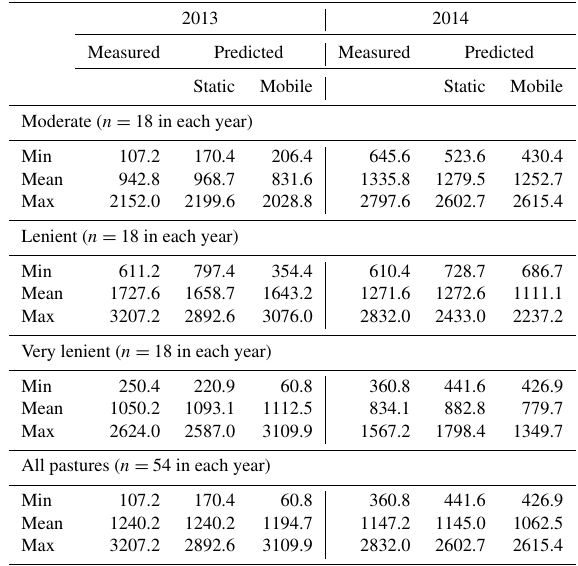
Table 3. Summary statistics of measured and predicted biomass (g FMm − 2 ) based on predictions by static and mobile application for pastures with different stocking rates in 2013 and 2014.